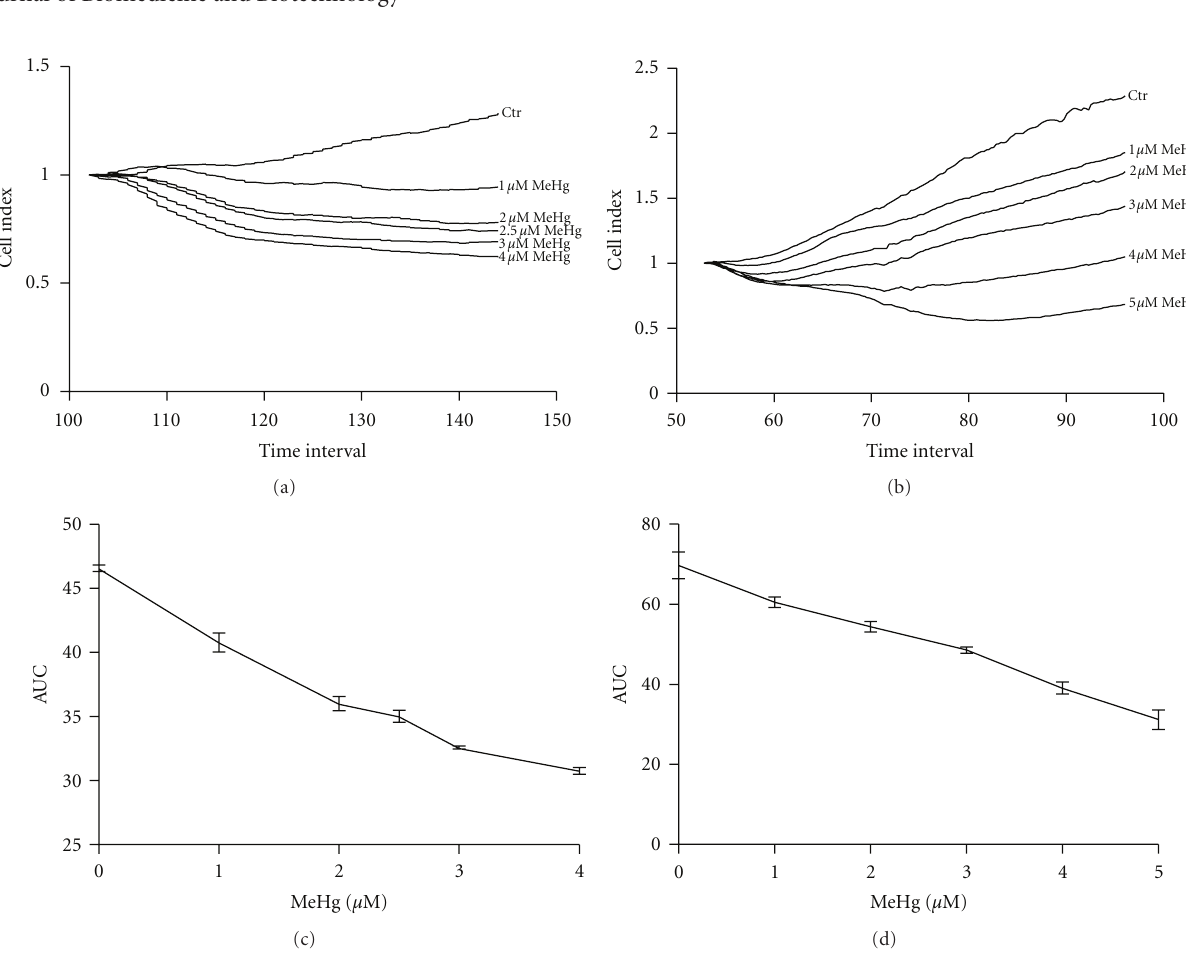
Figure 3: Titration of MeHg in ASK and HEK293 cell culture. (a) Growth pattern of ASK in xCELLigence after normalization. (b) Growth pattern of HEK293 in xCELLigence after normalization. (c) Area under curve from (timespan = 48h after MeHg exposure), representing loss of adherent cells or decreased growth in ASK cells. The dose response showed a nonlinear curve ( r 2 = 0 . 9824). (d) Area under curve (timespan = 48h after MeHg exposure), representing loss of adherent cells or decreased growth in HEK 293 cells. The dose response showed a linear curve ( r 2 = 0 . 9491).